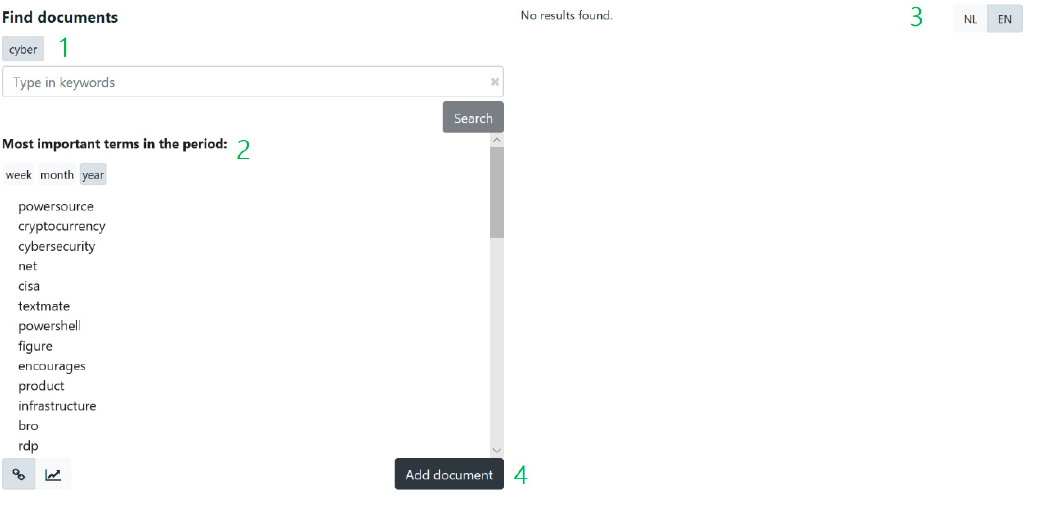
Figure 2. Start screen of the Horizon Scanner tool.